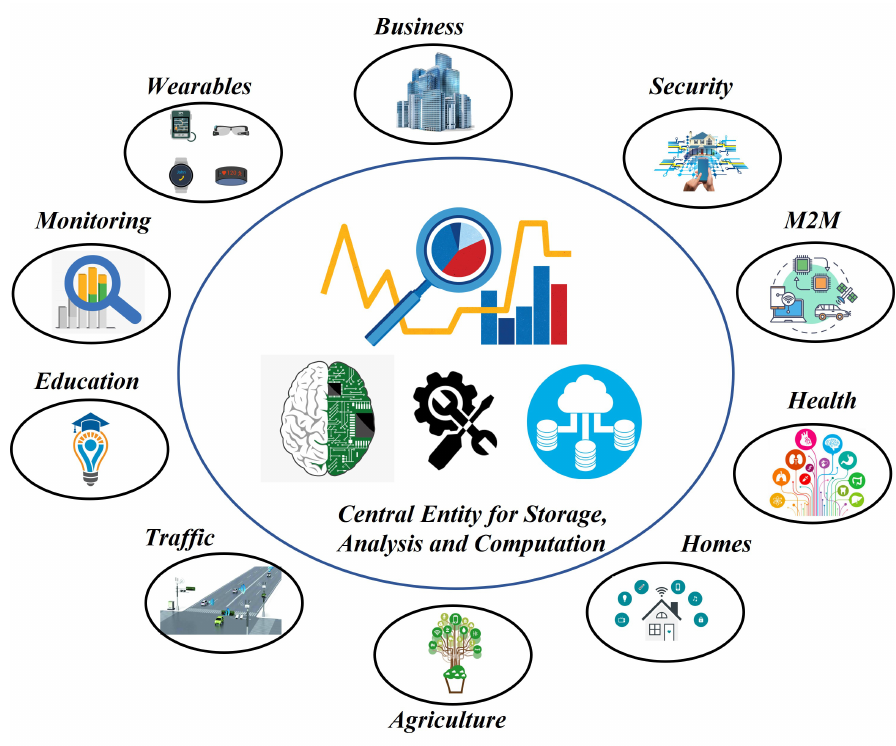
Figure 1. Overview of IoT